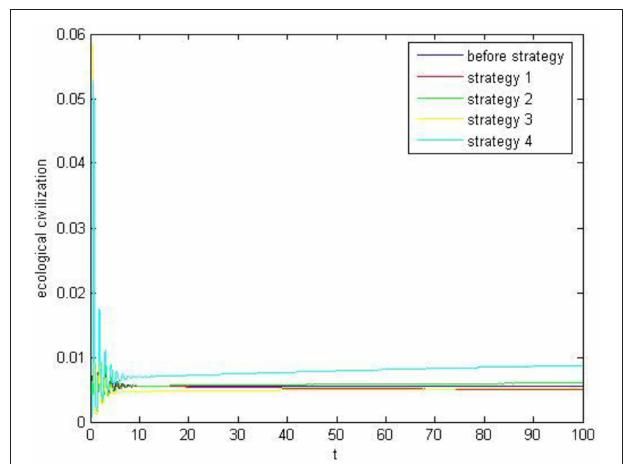
FIGURE 8 | Strategy map of ecological civilization